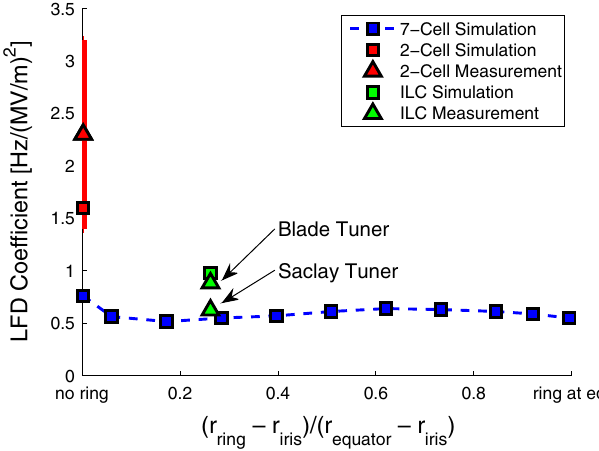
FIG. 17. Lorentz force detuning coefficients from ANSYS of the ERL injector and main linac cavities. The ILC cavity is also shown for comparison, with measurement reported from